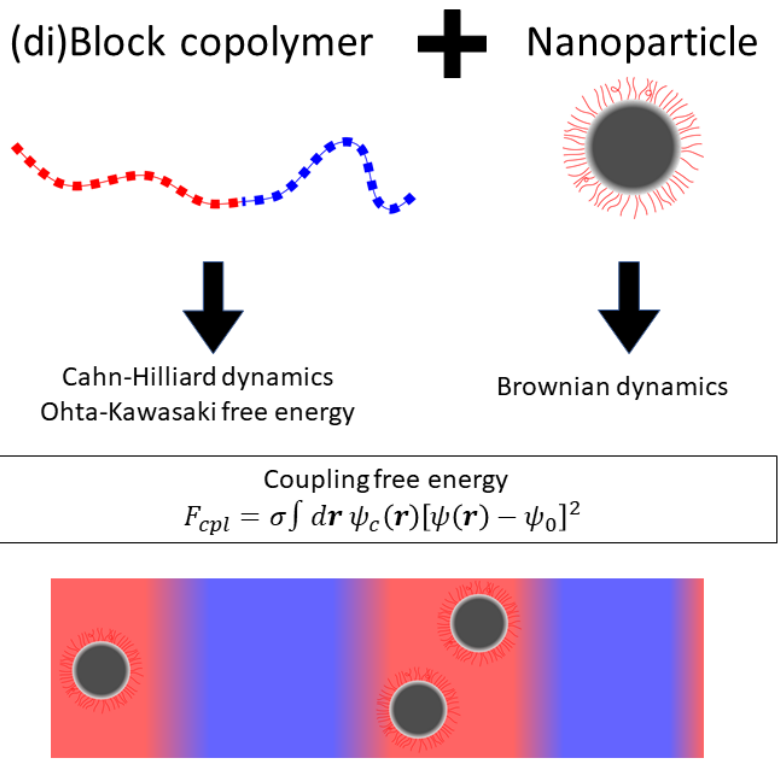
Figure 2. Schematic summary of the hybrid model described in Section